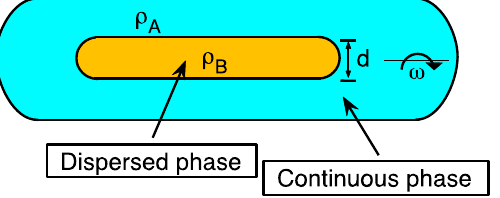
Figure 1. Spinning drop in the tensiometer capillary indicating the parameters necessary to calculate interfacial tension: the densities of the two phases ρ A and ρ B , the drop diameter d, and the rotational velocity ω rot .